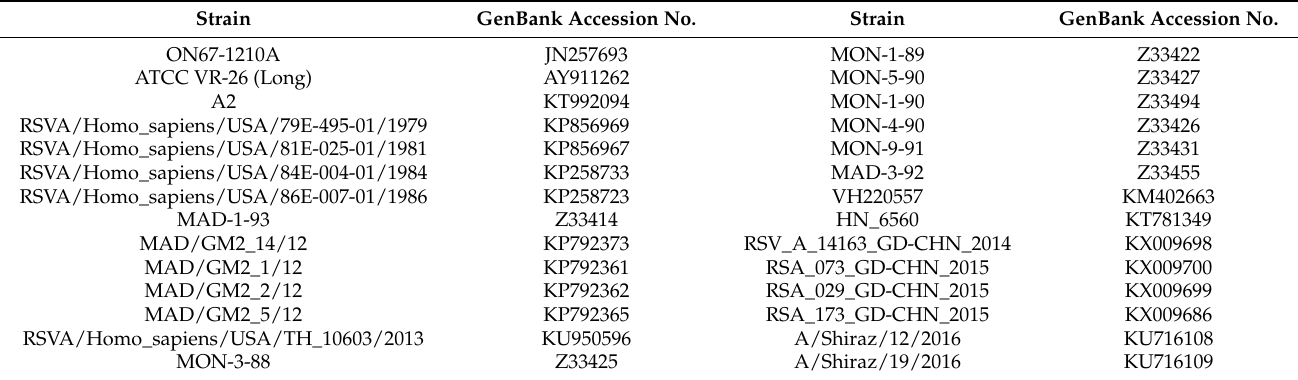
Table 2. RSV-A G protein’ gene GenBank